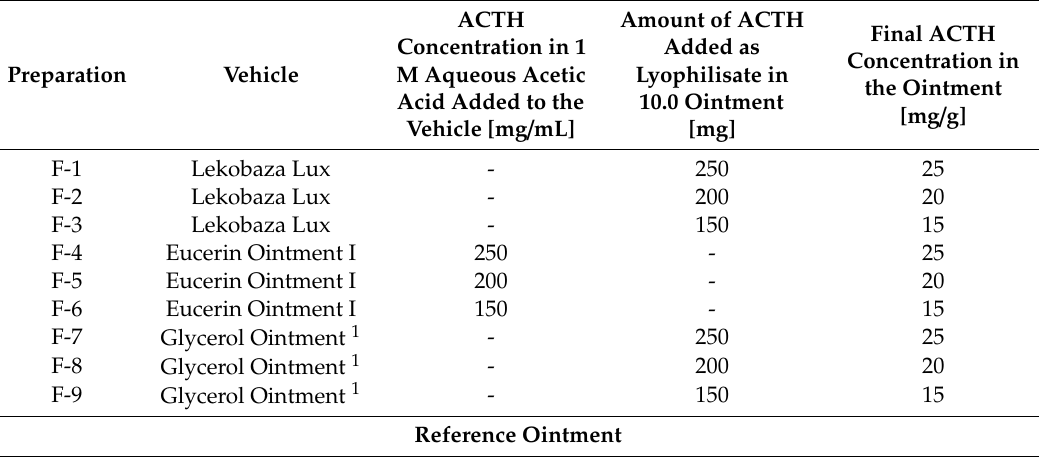
Table 6. Composition of prepared corticotropin ointments